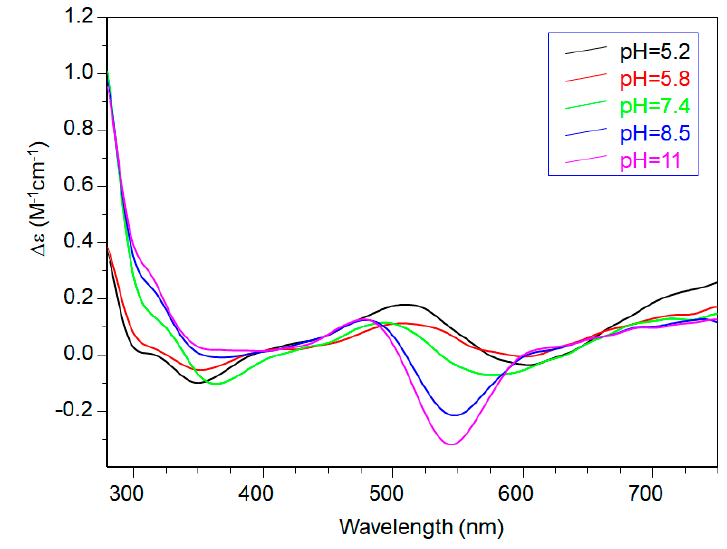
Figure 6. CD spectra of Cu(II)-Ac-SLHHLPG-NH 2 at different pH values at 1:2 metal-to-ligand molar ratio (L = 2 × 10 − 3 mol·dm − 3 ).